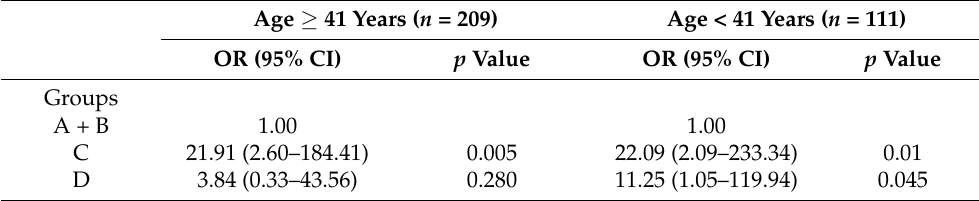
Table 8. Systemic reaction risk across the four groups by age group ( ≥ vs. <41